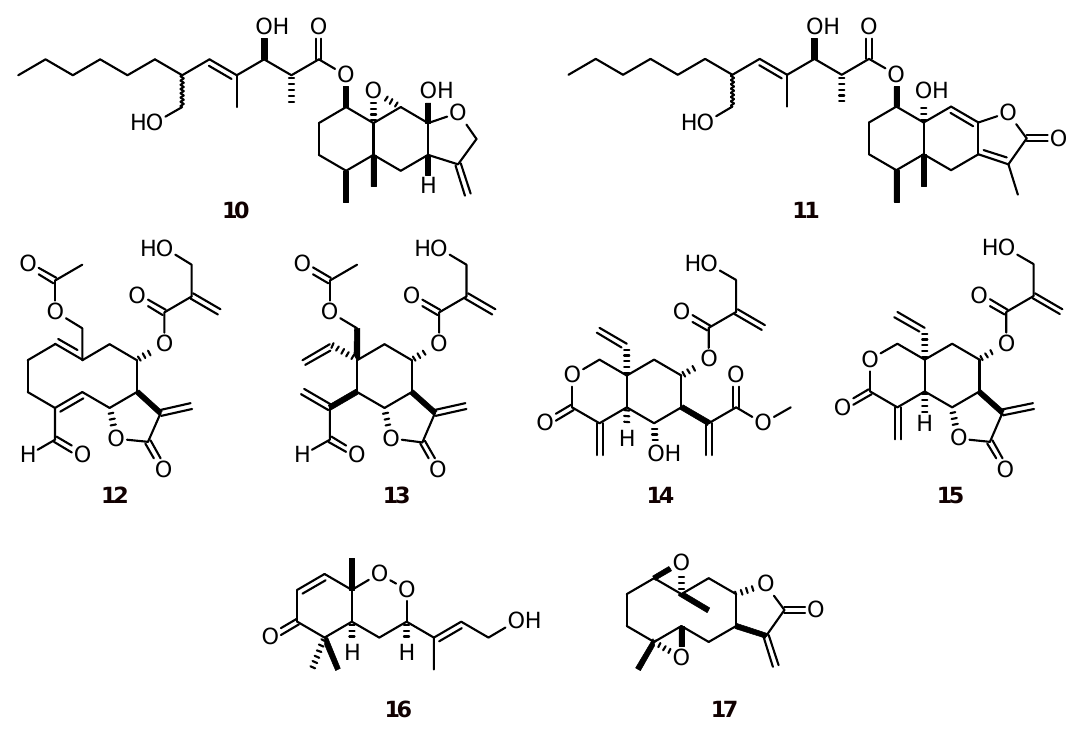
Figure 2. Structures of sesquiterpenes 10-17